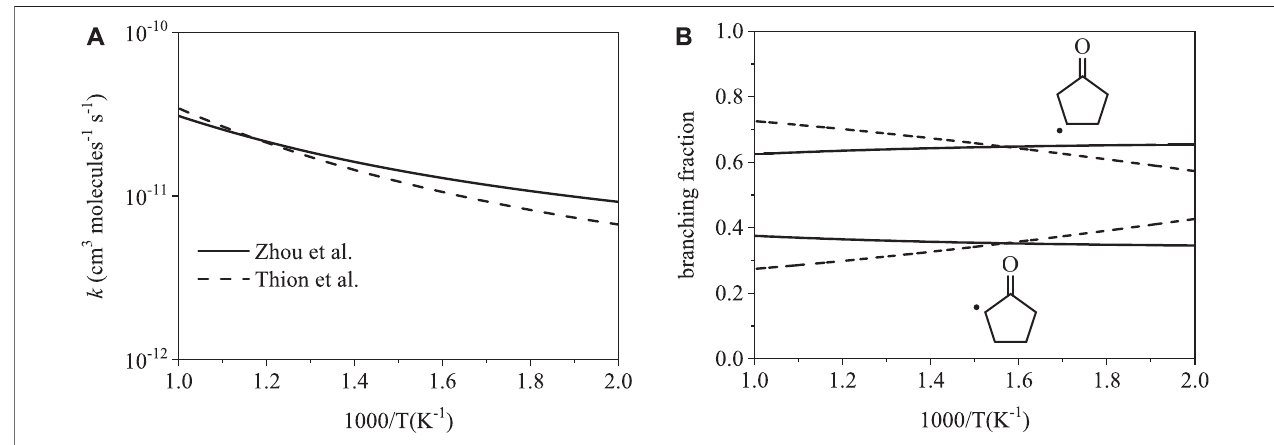
FIGURE4| Ratecoef fi cientsfromThionetal.(Sarathyetal.,2012)andZhouetal.(Zhouetal.,2016): (A) total, (B) site-speci fi c.Thetotalandsite-speci fi cratesare both similar from 500 – 1000 K.